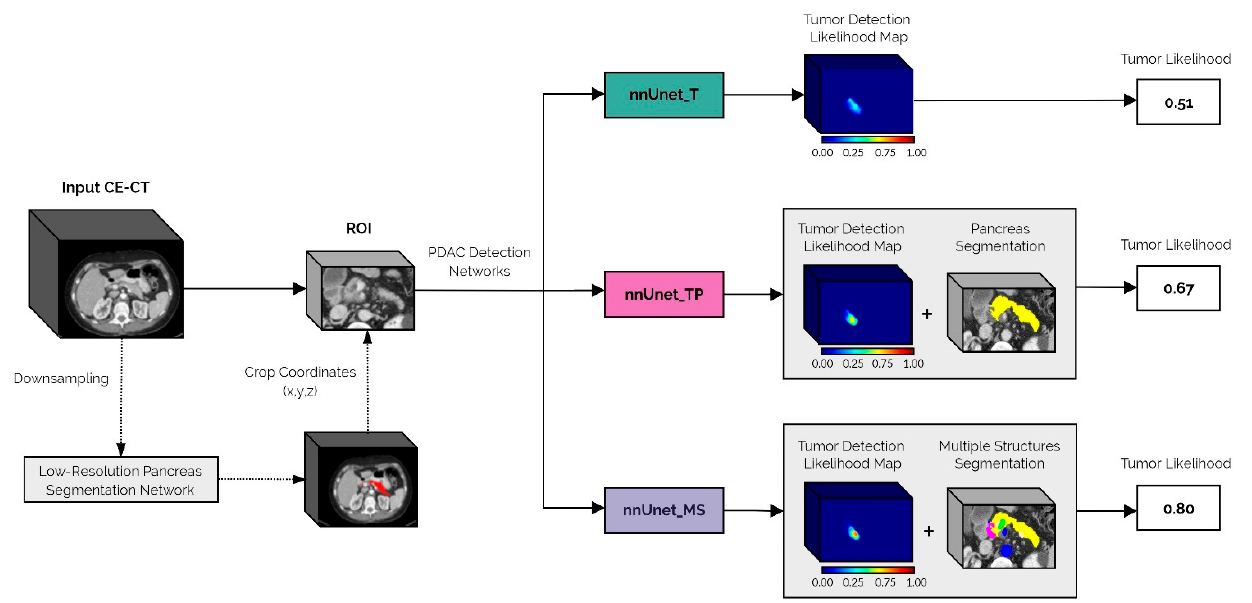
Figure 1. Schematic overview of the proposed automatic PDAC detection framework. The first step in the pipeline is to automatically extract the ROI from the full input CE-CT scan, using the low-resolution pancreas segmentation network. This ROI is then fed to each of the PDAC detection networks: nnUnet_T, nnUnet_TP, and nnUnet_MS . The final tumor likelihood output is derived from the networks’ tumor detection likelihood maps, which in the case of the nnUnet_TP and nnUnet_MS models, are post-processed using the automatically generated pancreas segmentation.